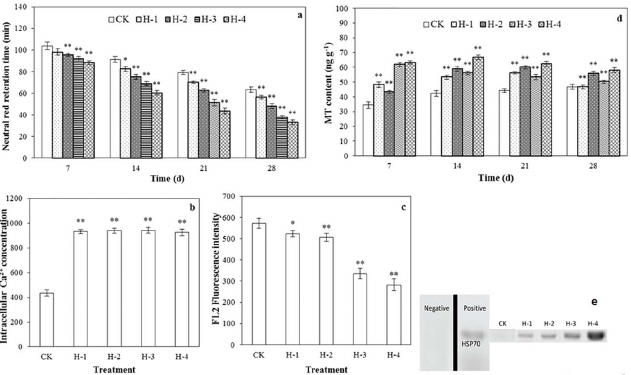
Fig 2. Cyto-toxicity of DEHP to E . fetida in the spiked soil test. (a) lysosomal membranestability characterized by neutral red retention time (NRRT), (b) concentration of intracellularcalcium ions and (c) potential difference in the mitochondrial membrane( ΔΨ m) measured by FL2 fluorescence intensity determined by flow cytometry assays; (d) metallothionein (MT) level determined with assay kits; and (e) heat shock proteins(HSP 70) determinedby western blot in extruded coelomocytes of treated E . fetida . (a) and (d) were determinedon days 7, 14, 21 and 28; (b), (c) and (e) were determinedon day 28 day after exposurein spiked natural soil; CK, H-1, H-2, H-3, and H-4 (n = 4; error bars, SEM). Refer to Fig 1 for details of other annotations (S1 Data).